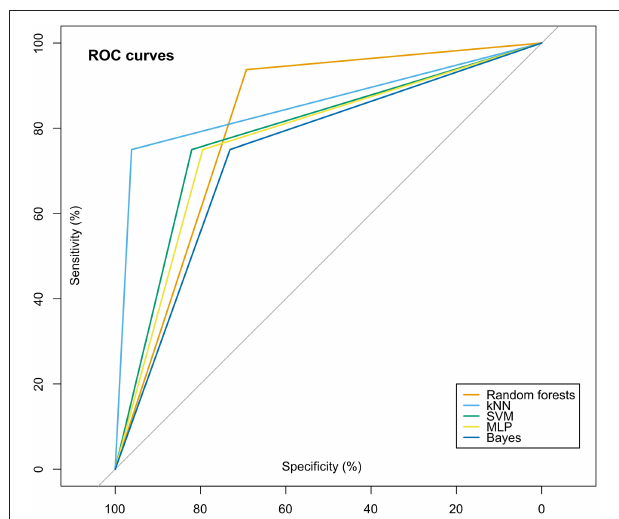
FIGURE 7 | Receiver operating characteristic (ROC) curves for the classifiers. For this example, the full data set was used for the prediction of trained algorithms implemented as random forests, k-nearest neighbors (kNN) support vector machines (SVM) multilayer perceptron [MLP or naïve Bayesian classifiers (Bayes)]. The figure has been created using the R software package [version 3.4.4 for Linux; http://CRAN.R-project.org/; ( 13)] and the R package “pROC” [https://cran.r-project.org/package=pROC;